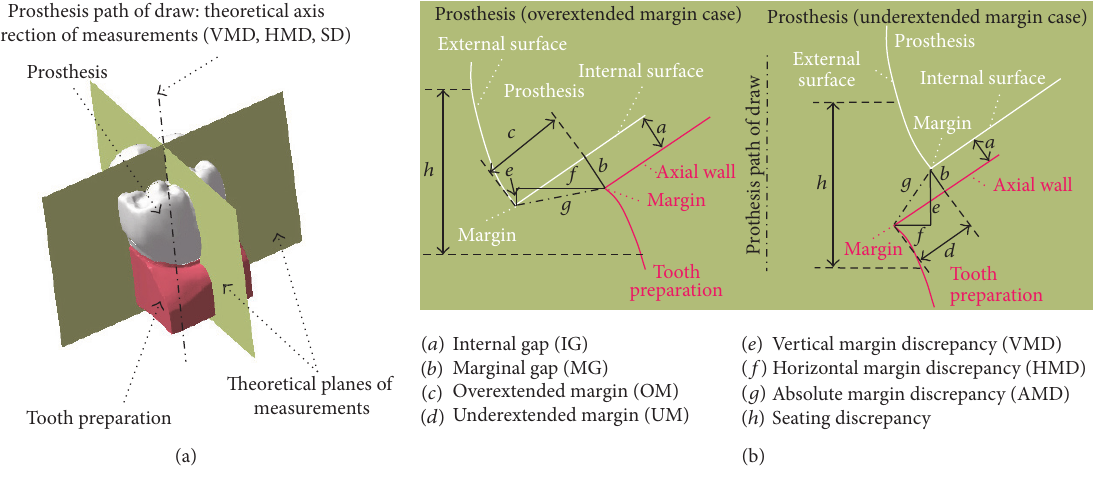
Figure 2: Definitions of adaptation criteria from Holmes et al.